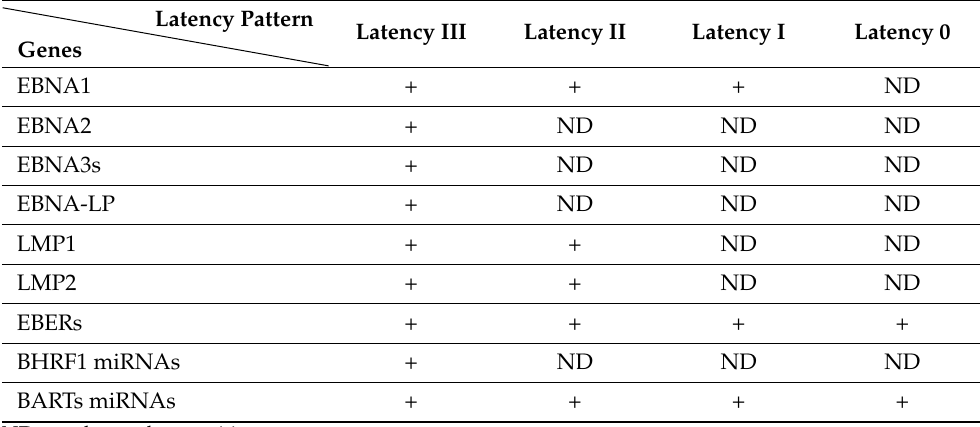
Table 1. EBV viral gene expression patterns during different types of latent